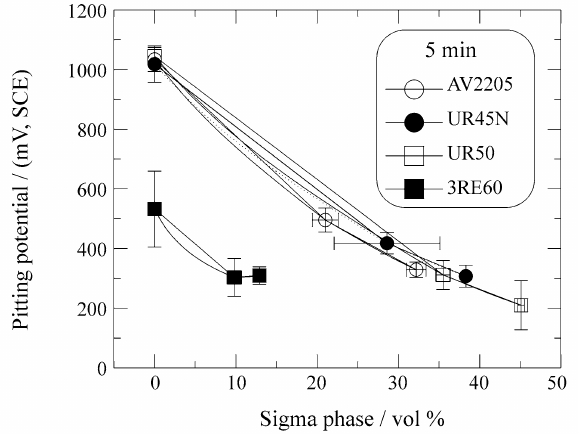
Figure 3. The pitting potential variation with the sigma phase volumetric percentage. The pitting potential was determined in 3.5% NaCl aqueous solution with a scanning rate of 1 mV/s started 5 min after the immersion of the sample inside the